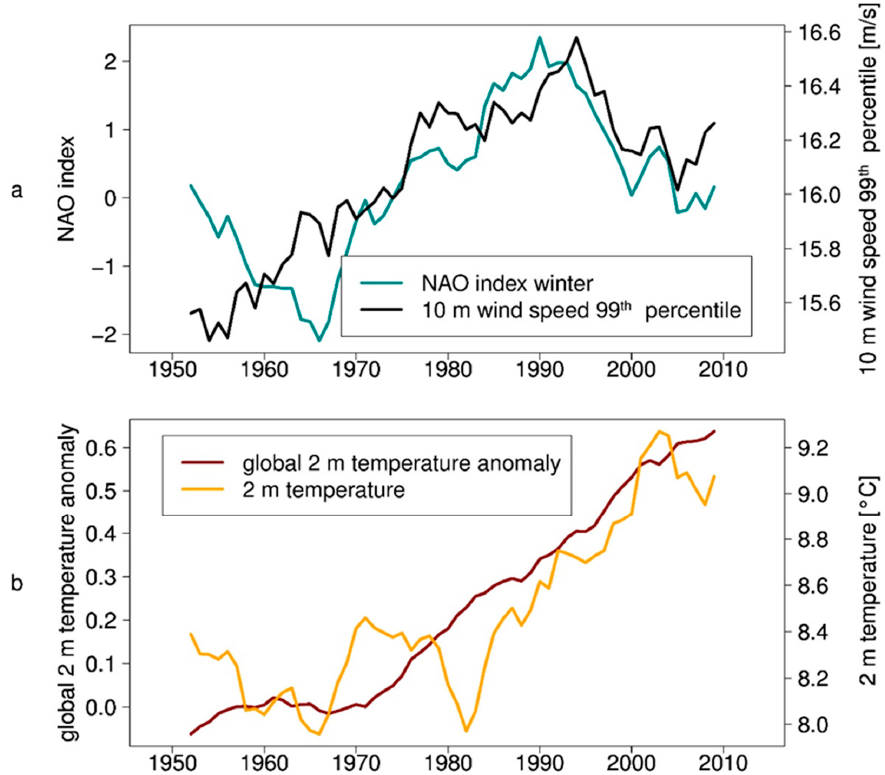
Figure 4. 10 years running mean between 1948 and 2014 of ( a ) NAO index [43] and 99th percentile of 10 m wind of GB0028 and ( b ) global 2 m temperature anomaly (base period: 1901–2000) [44] and 2 m temperature of GB0028 (model domain mean).